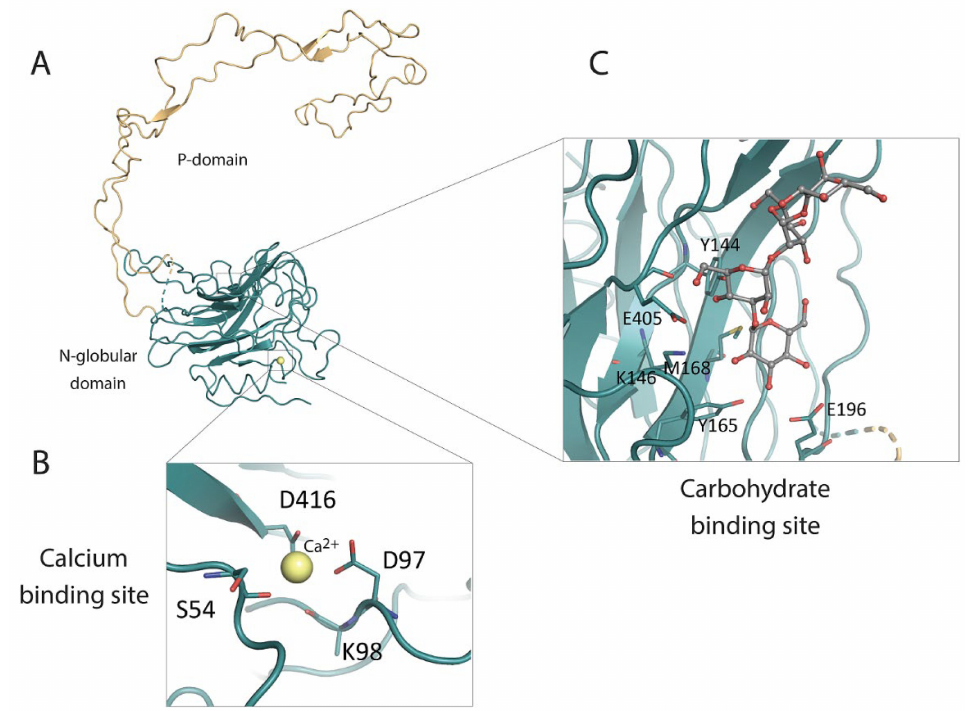
Figure 4. Crystal structure of the calnexin luminal domain and its characteristics. ( A ) Crystal structure of the calnexin intraluminal domain. The globular N-globular domain is shown in green while the P-domain is depicted in yellow. ( B ) Calnexin putative Ca 2+ -binding site, showing a Ca 2+ ion (yellow circle) coordinated by Asp 416 , Asp 97 , Ser 54 and potentially Lys 98 . ( C ) Calnexin carbohydrate binding site, showing the sidechains of Tyr 144 , Lys 146 , Tyr 165 , Glu 196 , Glu 405 and Met 168 involved in the binding of carbohydrate